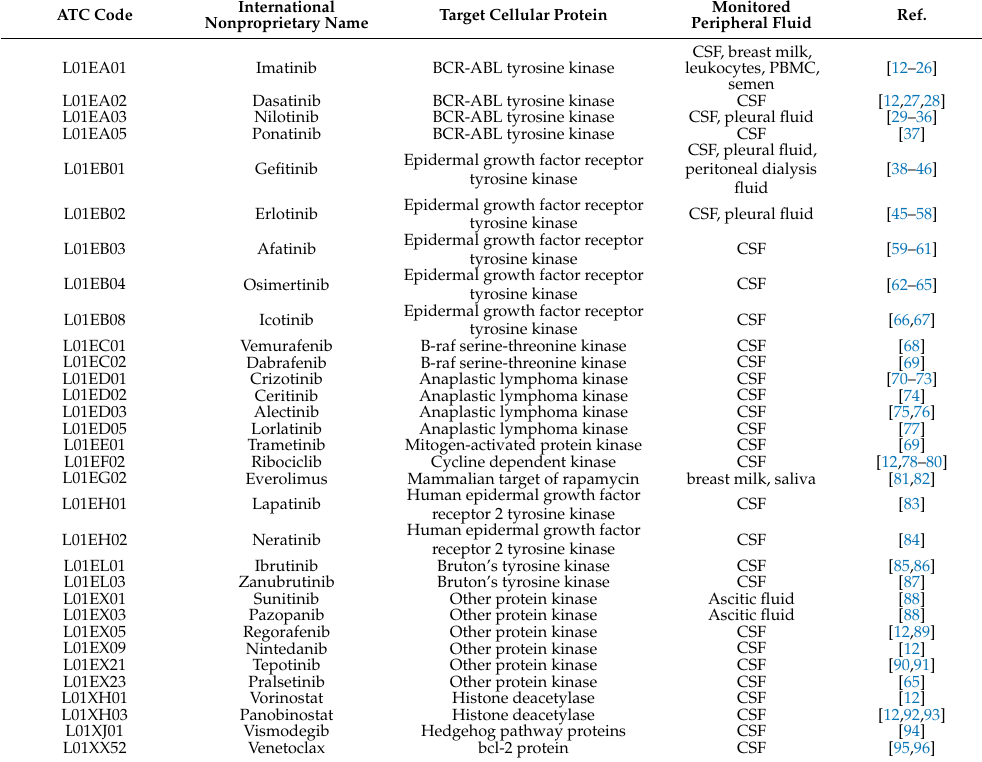
Table 1. Orally taken, small-molecule anticancer medications with specific cellular protein targets which have been measured in peripheral fluid spaces to support clinical decision making. CSF, cerebrospinal fluid; PBMC, peripheral blood mononuclear